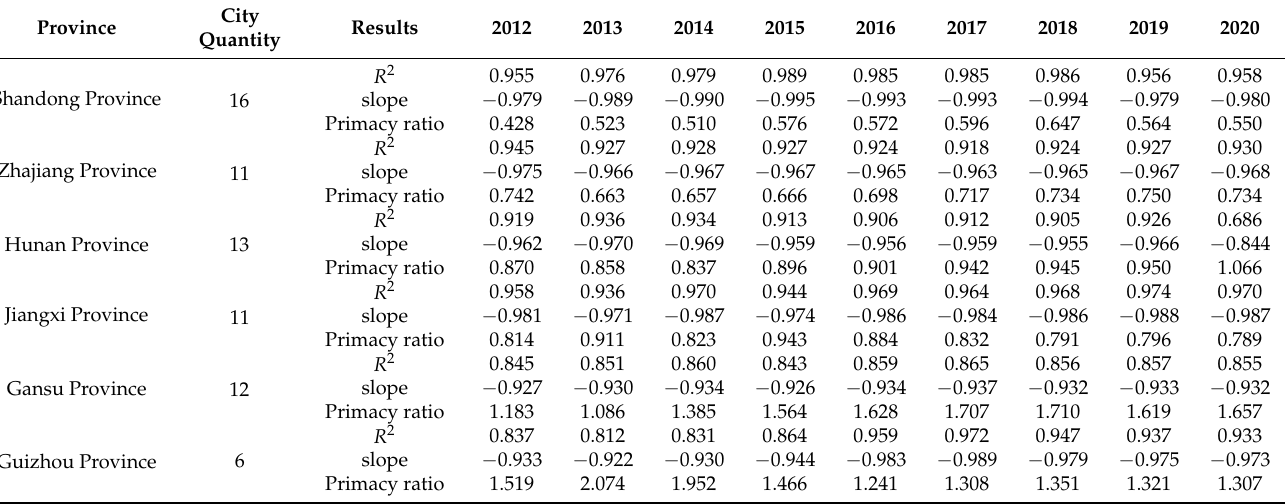
Table 6. Urban scale of some provinces in